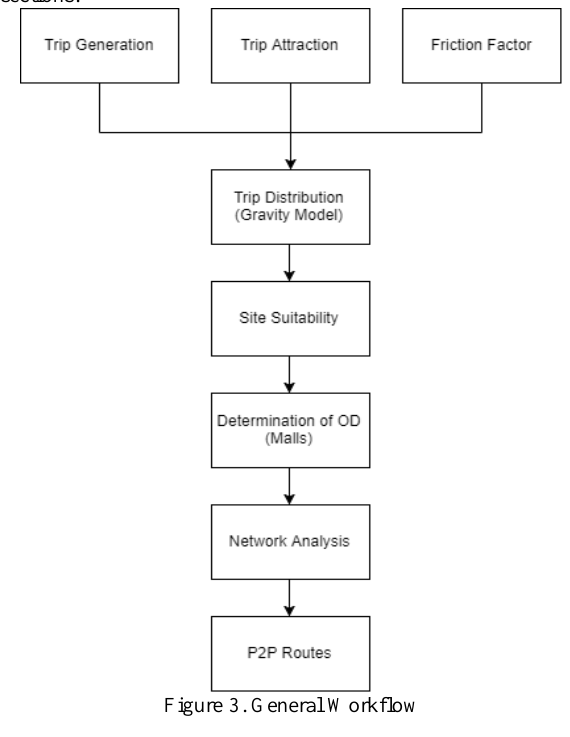
Figure 3. General